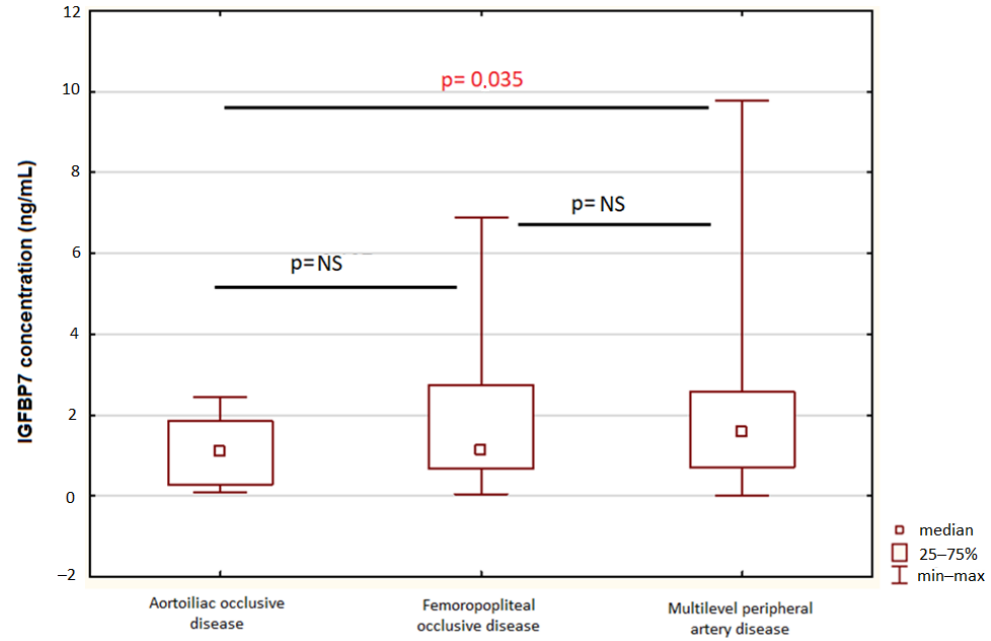
Figure 2. IGFBP-7 concentrations in patients with aortoiliac, femoropopliteal, and multilevel PAD. Abbreviations: IGFBP-7—insulin-like growth-factor-binding protein 7.